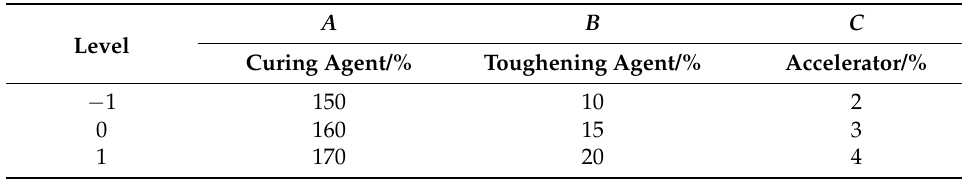
Table 1. Test factors and levels.